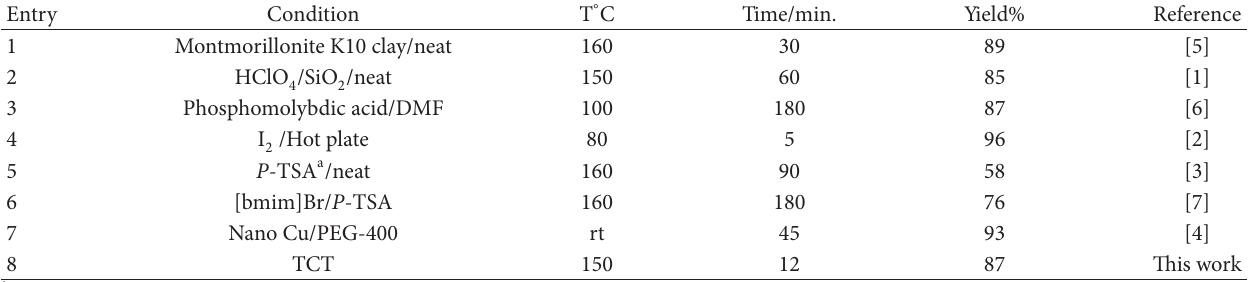
T 3: Comparison of efficiency of various catalysts in synthesis of 1,2-dihydro-1-phenylnaphtho[1,2-e][1,3]oxazin-3-one.